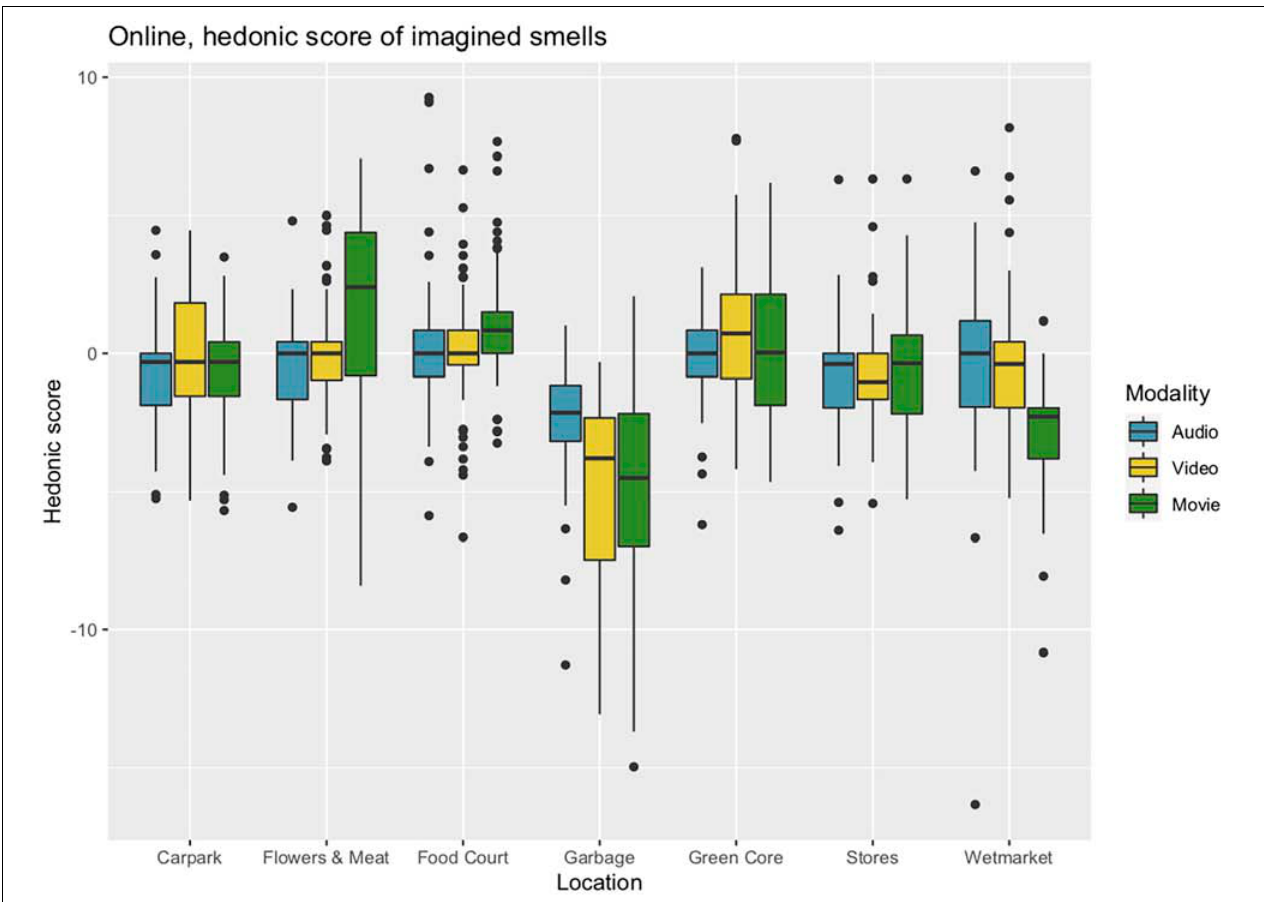
FIGURE 9 | Boxplots of cumulative hedonic scores for seven locations and three modalities, estimated from free-form descriptions of imagined smells by raters ( N = 53) matched against previous data (Dravnieks et al., 1984).